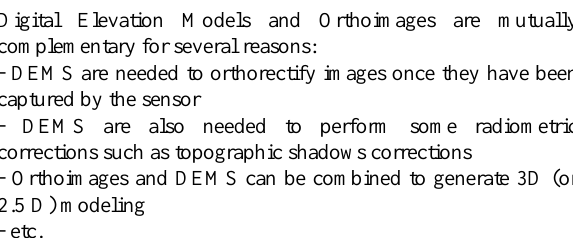
Table 15. Third and fourth columns show pixel sizes of Secant Web Mercator tiling schema with reference latitude 33.144º and map scales on a 254 dpi screen at the same reference